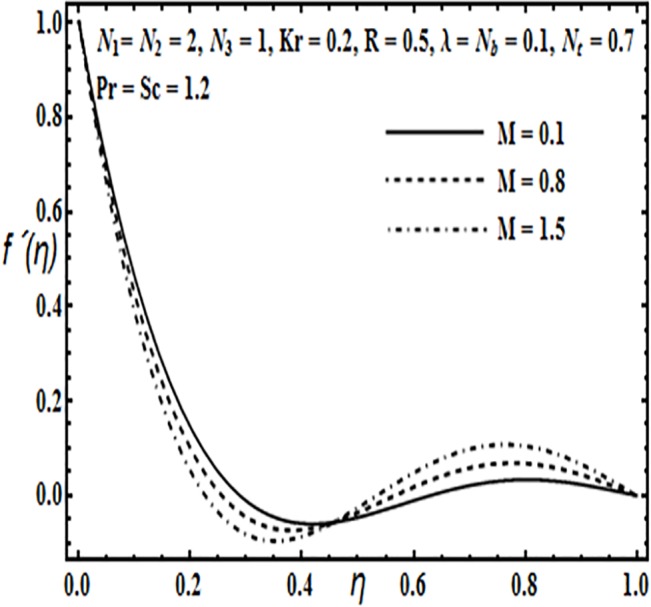
Effect of M on f′(η).